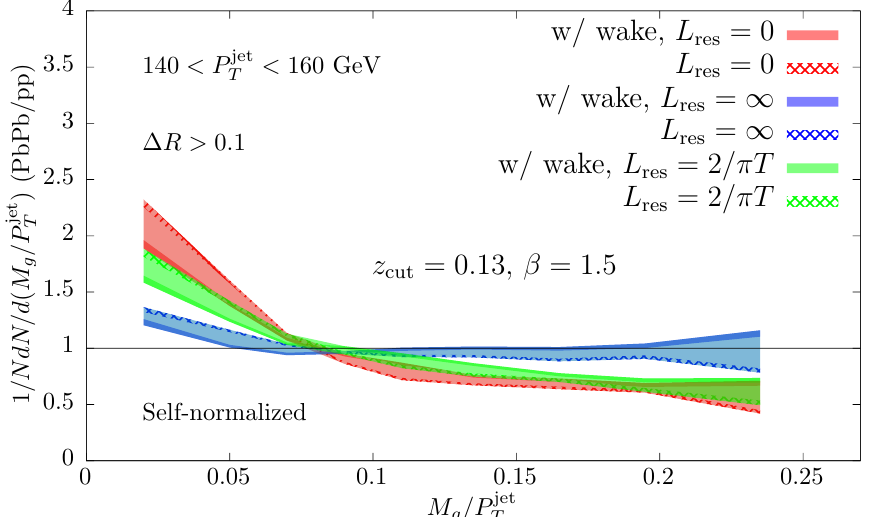
Figure 8 . Results from the hybrid model calculations of the ratio between the self-normalized p M g =p jet distributions in PbPb and pp collisions at s = 5 : 02 ATeV for 0{5% centrality class, for T R = 0 : 4 jets, obtained using the soft-core grooming procedure, and computed for di(cid:11)erent values of L res . Dashed curves are obtained ignoring the soft particles coming from the wake in the medium, while solid curves do include them. The space in between is shaded for each choice of L res so as to better expose the relative sensitivity of the observable to the e(cid:11)ects of the wake (width of each individual colored shading) and the e(cid:11)ects of our choice of L res (separation between the di(cid:11)erent